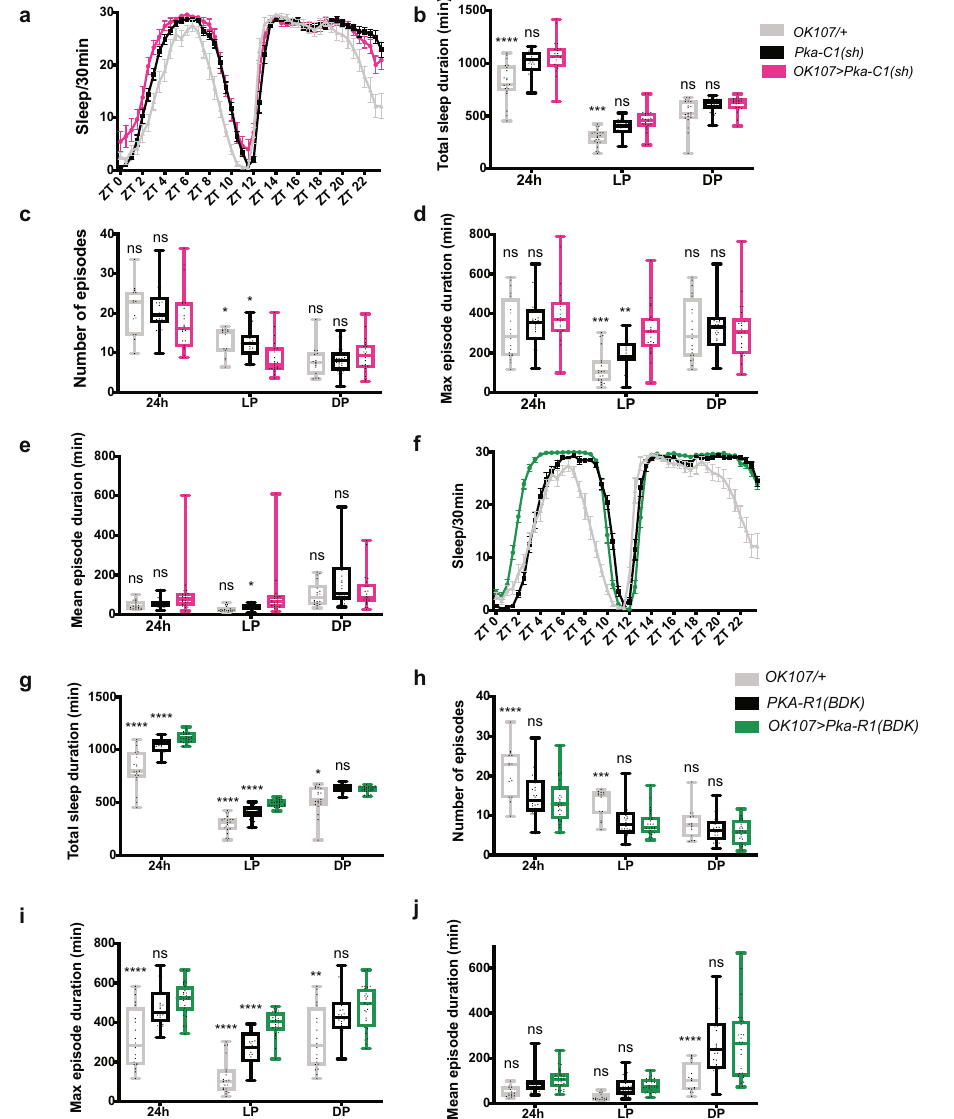
Fig. 6 PKA-C1 activity in the MB promotes daytime wakefulness. a – e Sleep pro fi les, amount, and structure of OK107 > Pka-C1 ( sh ), GAL4-only control ( OK107 / + ), and UAS-only control ( Pka-C1 ( sh )/ + ) fl ies ( n = 21 – 32 per group). Values of OK107 > Pka-C1 ( sh ) were compared with those of OK107 / + and Pka-C1 ( sh )/ + using two-way ANOVA with Dunnett ’ s multiple comparisons test (* p < 0.05, ** p < 0.01, *** p < 0.001, and **** p < 0.0001). The center lines of the boxplots indicate the median, box boundaries are 25th and 75th percentiles, and the whiskers represent the minimum and maximum values. a Sleep per 30 min bin averaged over 5 days during LD. Data are represented as mean values ± SEM. b Total sleep duration. c Number of sleep episodes. d Maximum sleep episode duration. e Mean sleep episode duration. f – j Sleep pro fi les (mean ± SEM) and analysis results of OK107 > PKA-R1 ( BDK ), OK107 / + , and PKA-R1 ( BDK )/ + fl ies ( n = 14 – 30 per genotype). The boxplots are as in b – e . Values of OK107 > PKA-R1 ( BDK ) were compared with those of both controls using two-way ANOVA with Dunnett ’ s multiple comparison ’ s test (** p < 0.01, *** p < 0.001, and **** p < 0.0001). Source data are provided as a Source Data fi